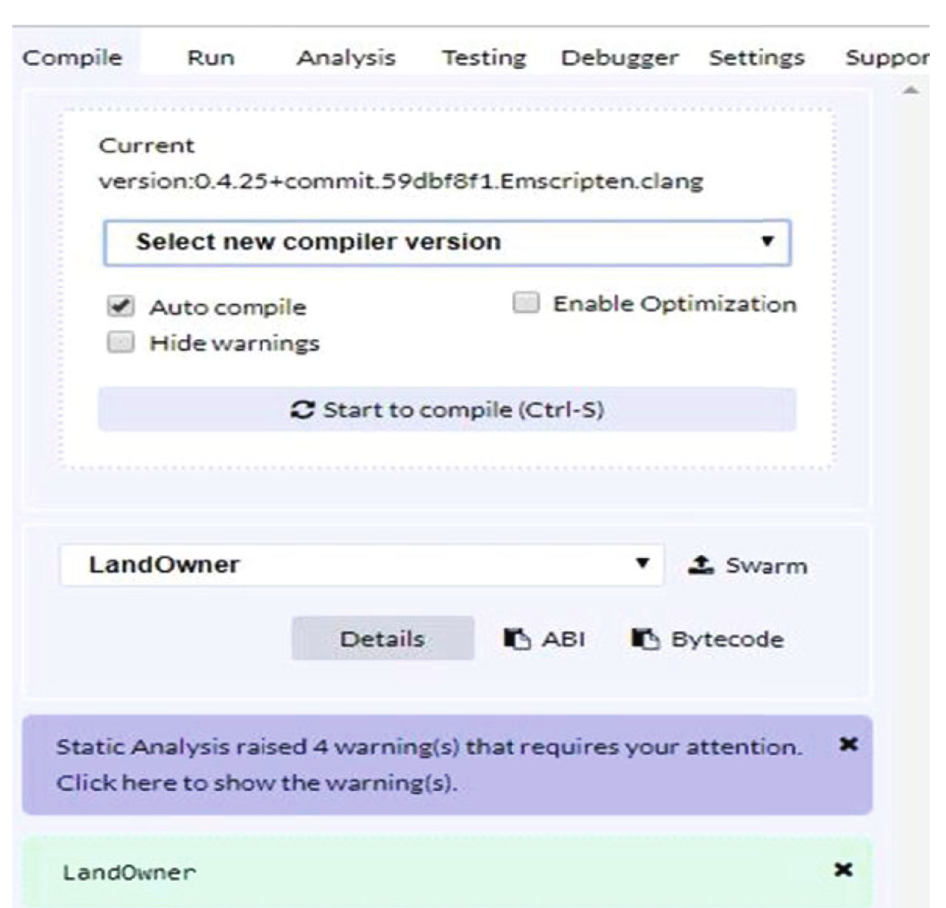
Figure 14: Compilation